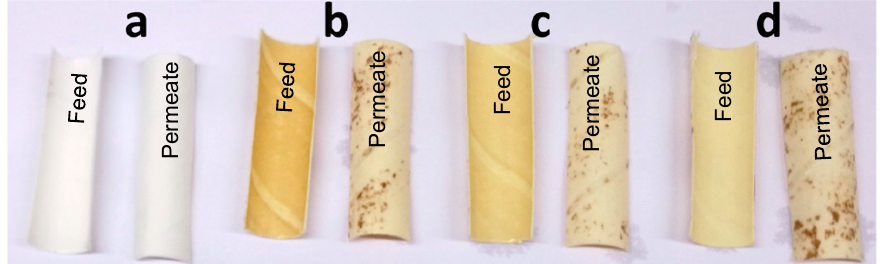
Figure 1. Visual appearance of the feed side and permeate side of: ( a ) a pristine membrane, ( b ) a fouled membrane, ( c ) a membrane cleaned for 1 h with the alkaline cleaning agent, and ( d ) a membrane cleaned for 20 h with the alkaline cleaning agent.